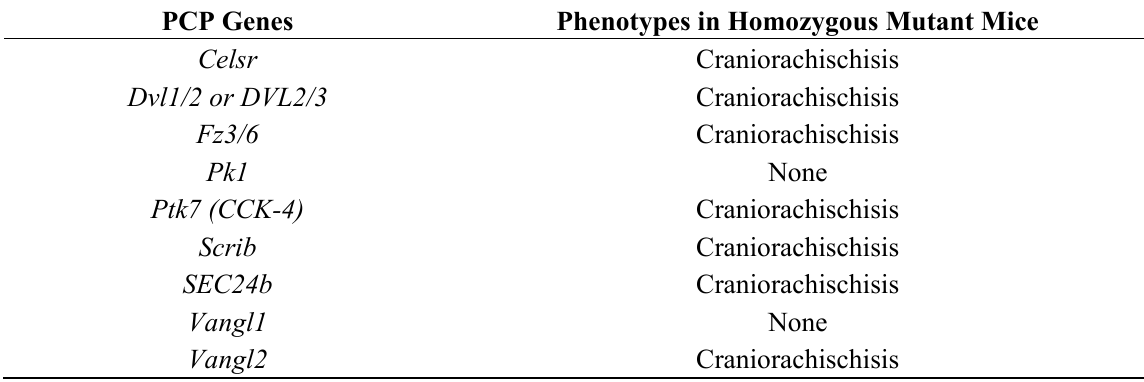
Figure 1. Representation of scanning electron micrographs of E13 curly tail mouse embryos suffering from neural tube defects (NTDs) (adapted from [35]): ( a ) embryo classified as unaffected phenotype; ( b ) embryo showing spina bifida and dorsally flexed tail; ( c ) embryo of severely affected phenotype showing exencephaly. Table 1. Summary of mutations in planar cell polarity (PCP) genes and their phenotypes in